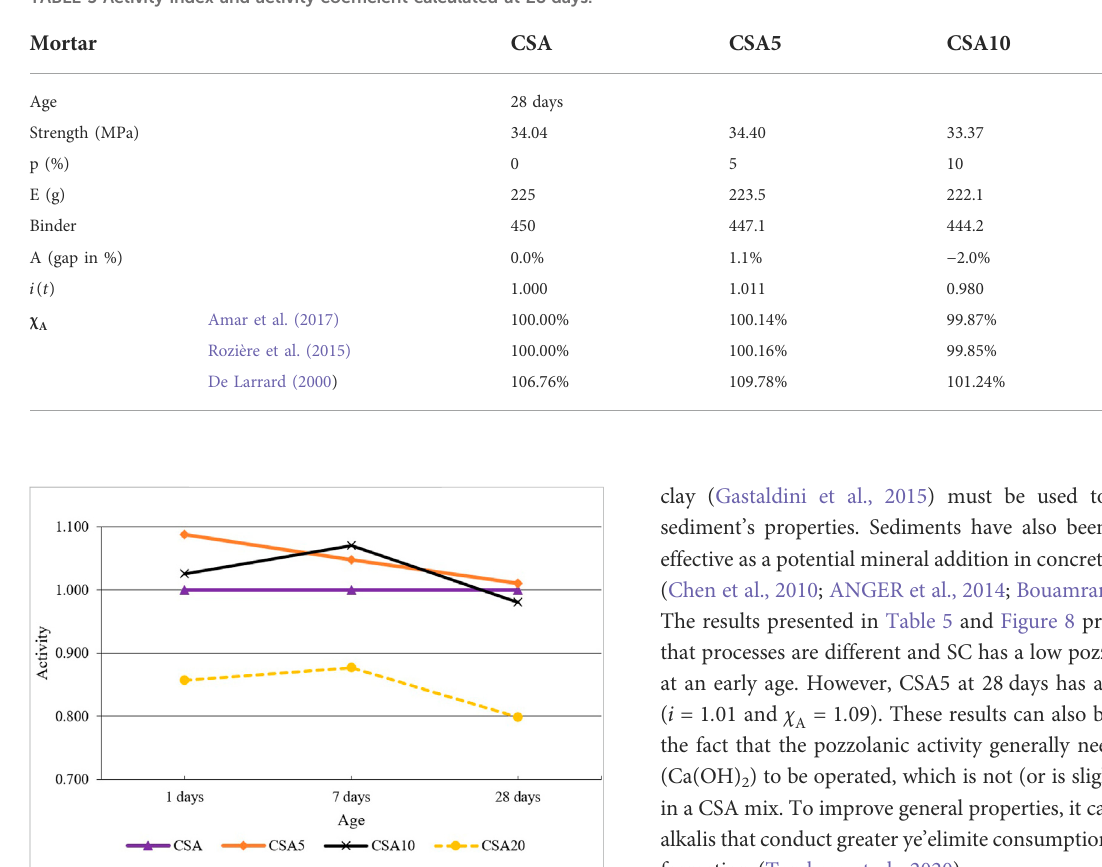
FIGURE 8 Activity monitoring